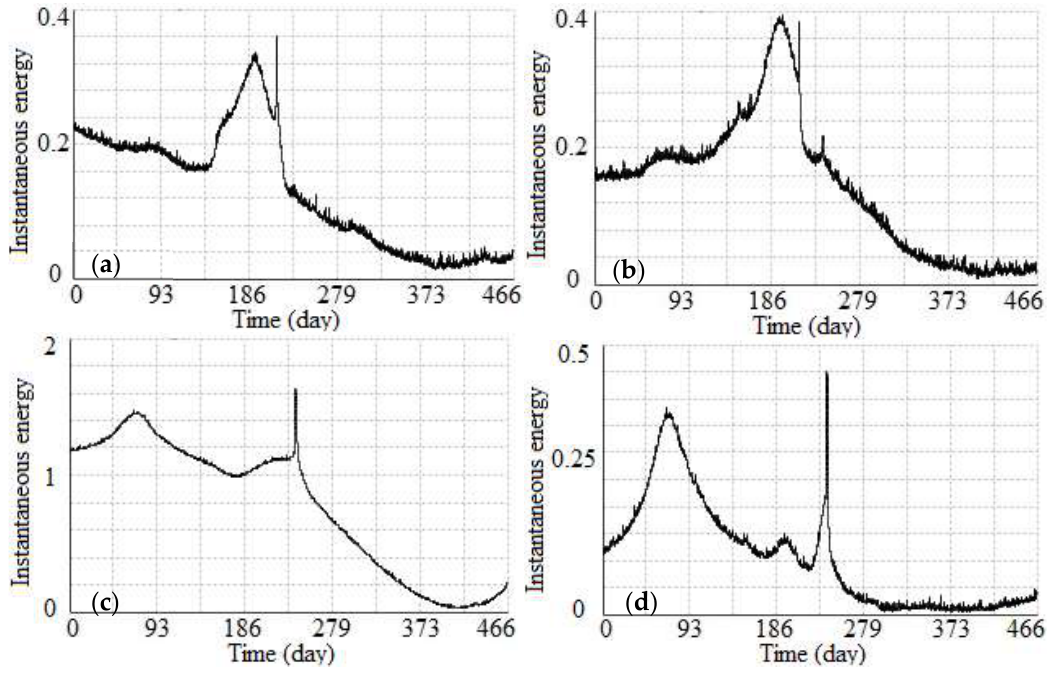
Figure 11. Instantaneous total energy of the 4th and 5th nodes in the X and Y directions of the 4 m-long SAA. ( a ) X direction of the 4th node; ( b ) X direction of the 5th node; ( c ) Y direction of the 4th node; ( d ) Y direction of the 5th node.